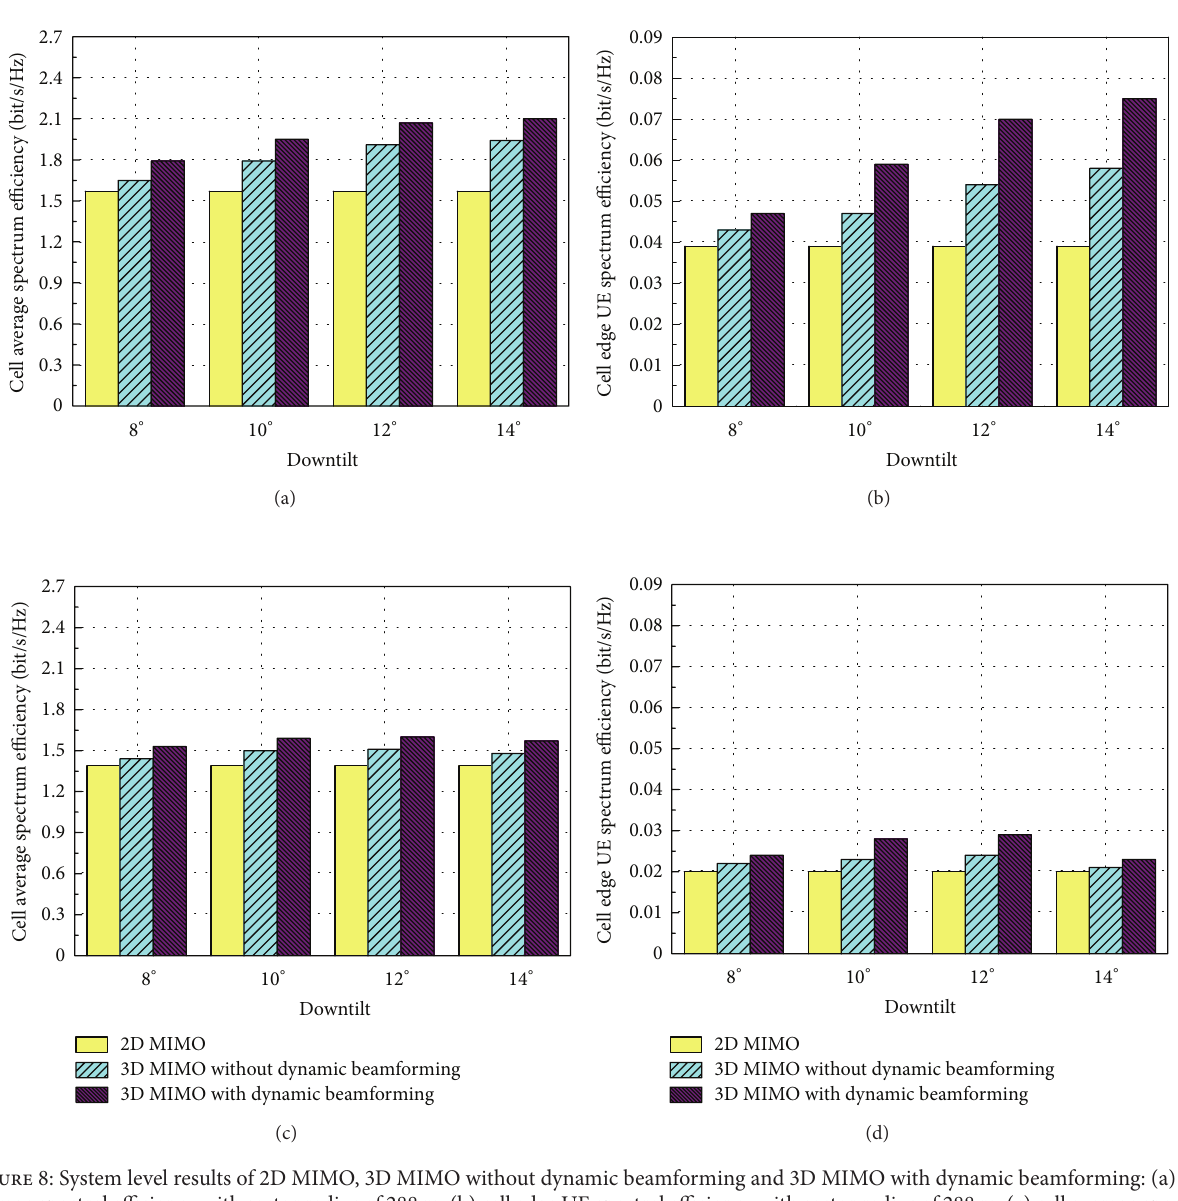
Figure 8: System level results of 2D MIMO, 3D MIMO without dynamic beamforming and 3D MIMO with dynamic beamforming: (a) cell average spectral efficiency with sector radius of 288 m; (b) cell edge UE spectral efficiency with sector radius of 288 m; (c) cell average spectral efficiency with sector radius of 500m; (d) cell edge UE spectral efficiency with sector radius of 500